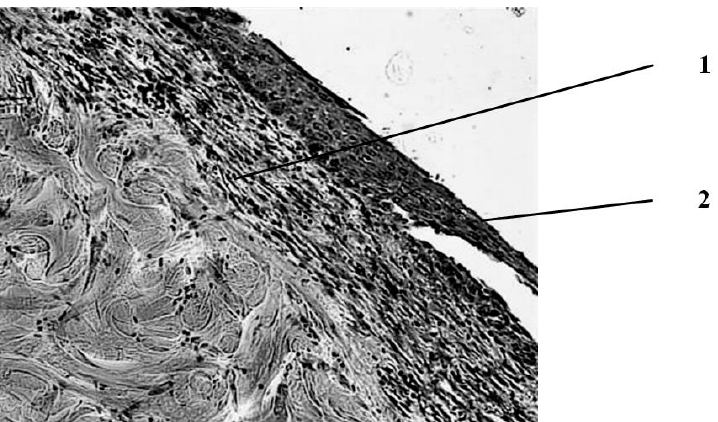
Figure 6. Morphological picture of the skin 14 days after the burn in case of wound treatment with Levomecol ointment. 1 — young scar tissue; 2 — newly formed epidermis. Stained with hematoxylin Levomecol ointment. 1—young scar tissue; 2—newly formed epidermis. Stained with hematoxylin and eosin. magn. ×100. and eosin. magn. ×